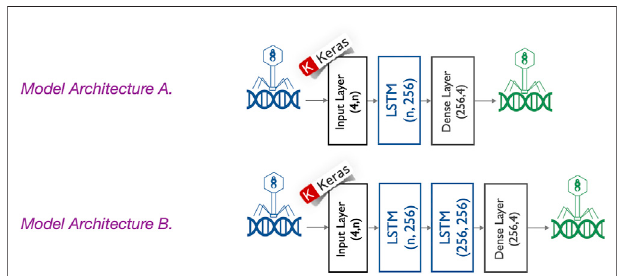
FIGURE5| Differentgeneratormodelarchitectures.Twodifferentmodel architectures are proposed. They are composed of an input layer, one or two hidden layers, and an output layer. The input layer takes sequences with n positions (where n = seed length) of four features, each counting for the one-hot encoded input sequences. Each hidden layer is an LSTM with 256 neurons. Architecture A is composed of one hidden layer, whereas the architecture B is composed of two hidden layers. The output layer is a fully connected layer with a softmax activation function to ensure the outputs are interpreted as the probability of membership for each class (i.e., the type of nucleotide).